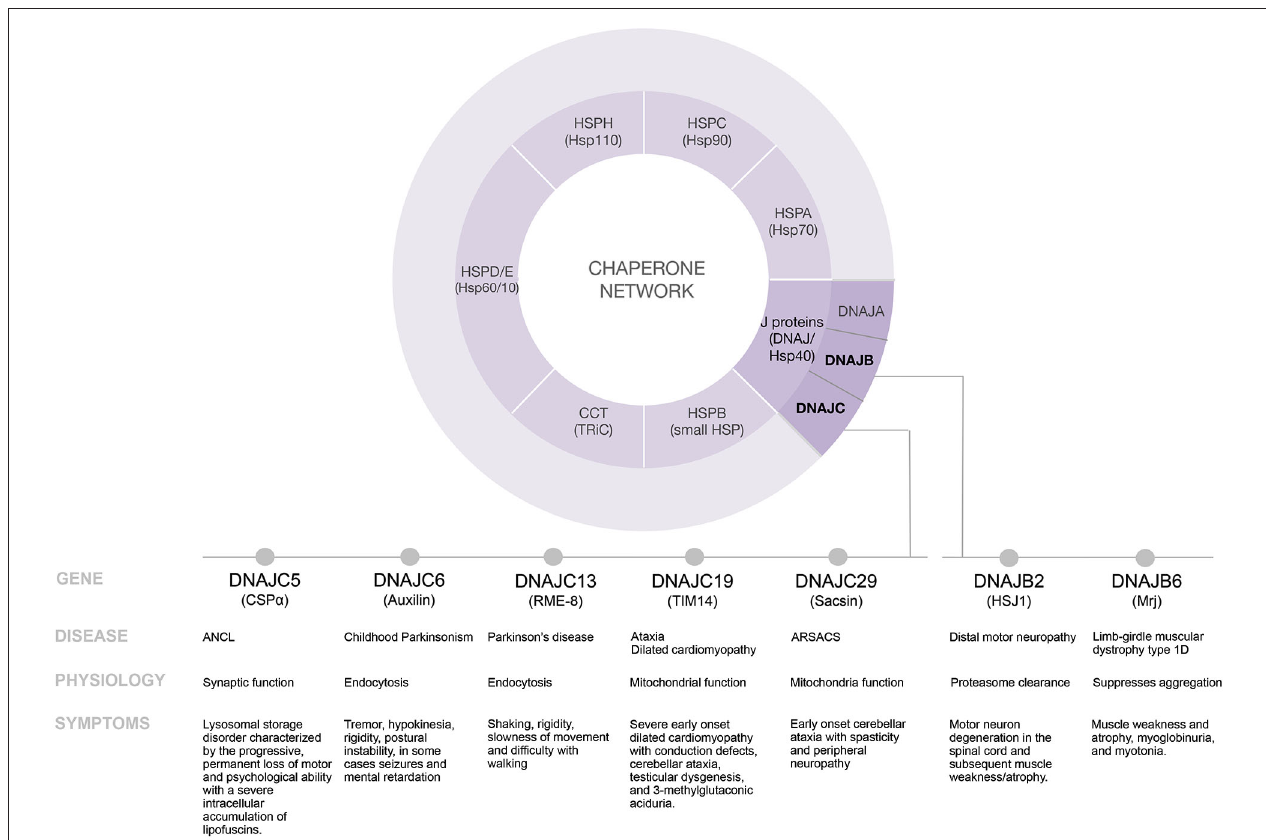
FIGURE 1 | Disease modifying pathways of select J